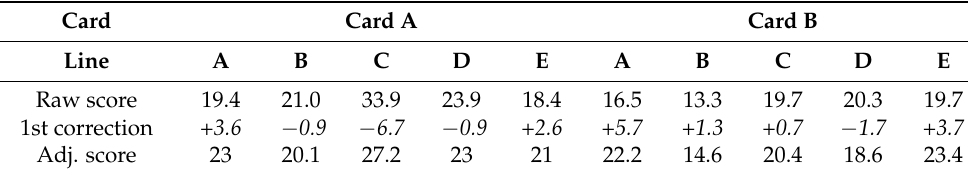
Table 13. Example 1 of application of GVT in one case: raw scores.